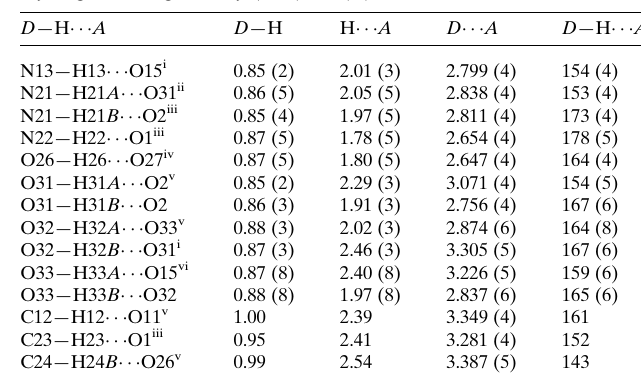
Table 2 Hydrogen-bond geometry (A˚ , (cid:3) ) for (II).